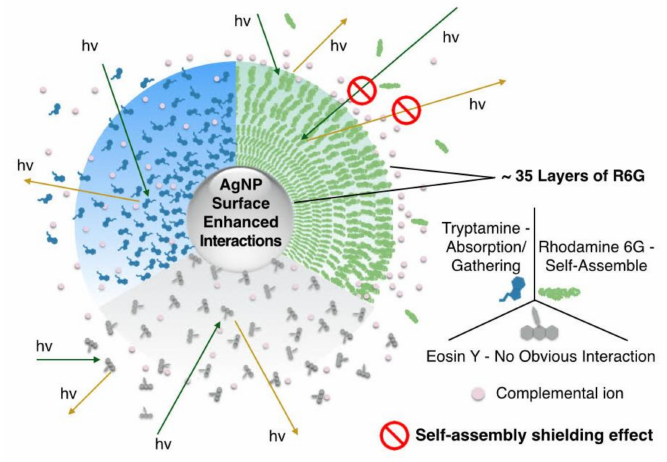
Figure 5. Schematic drawing of di ff erent types of interaction and behavior of various dye molecules,